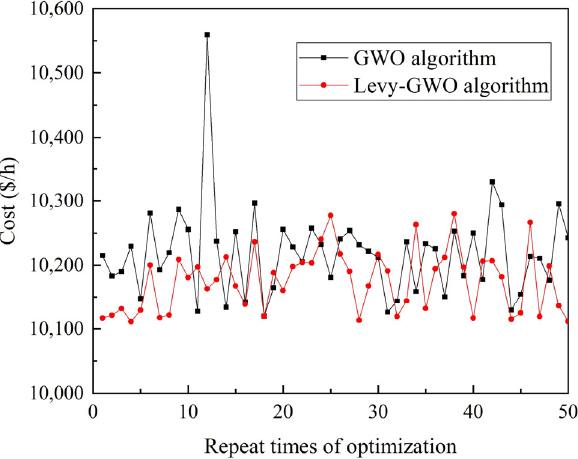
Figure 7. The distribution of calculated results of GWO and Levy–GWO algorithms.